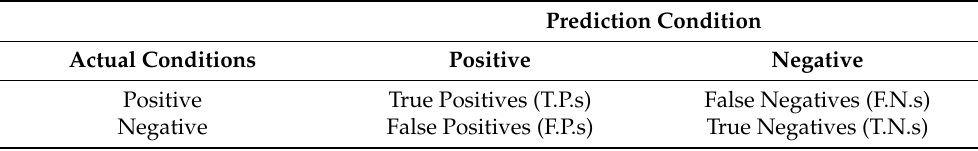
Table 4. Confusion matrix for evaluating model’s